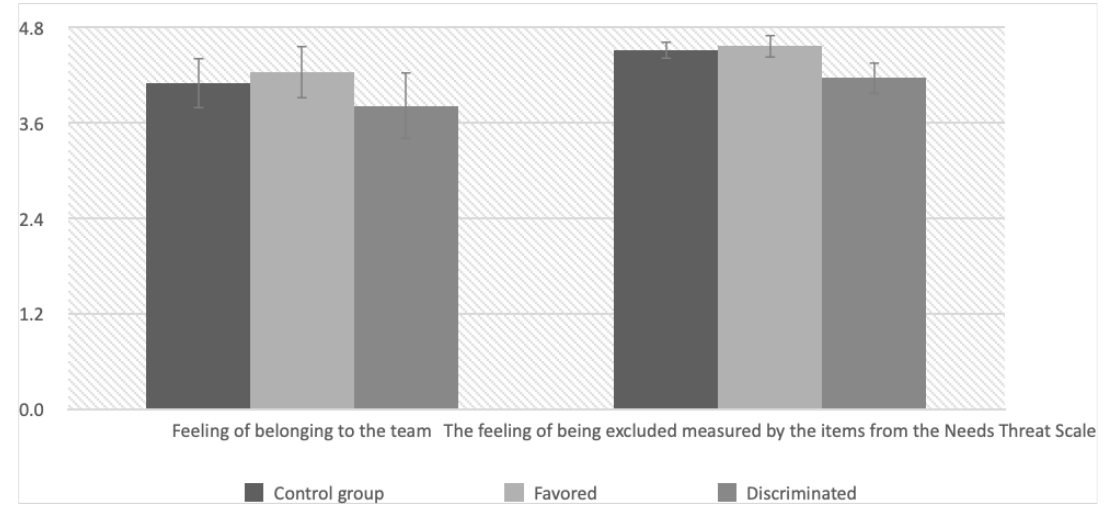
Figure 5. Means with 95% confidence interval for the feeling of belonging to the team and the feeling of being excluded from the team.